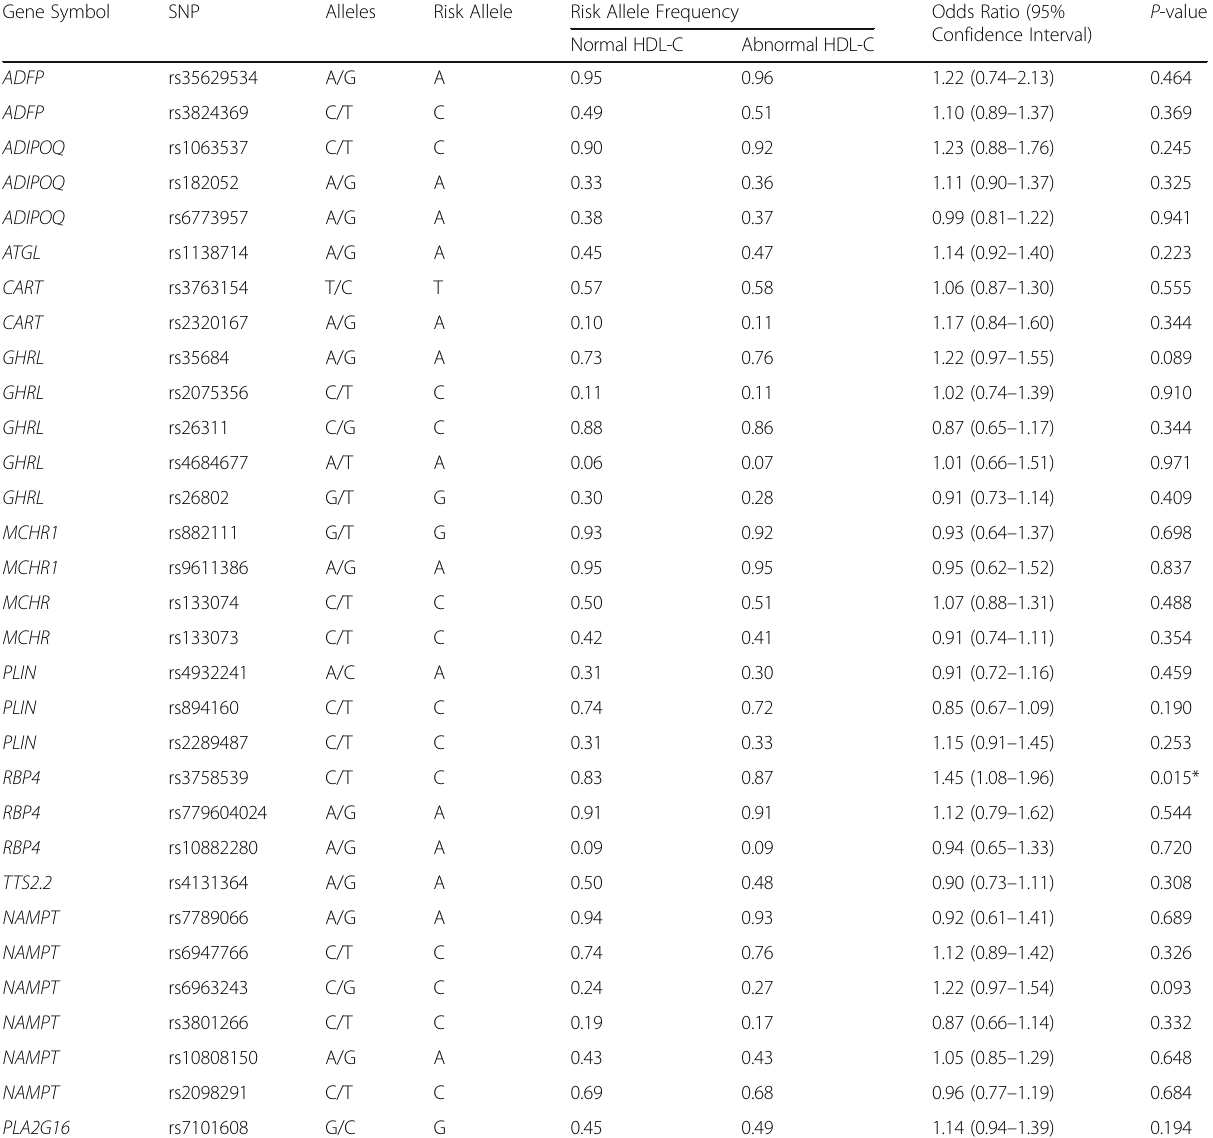
Table 2 SNP characteristics and multivariate logistics regression